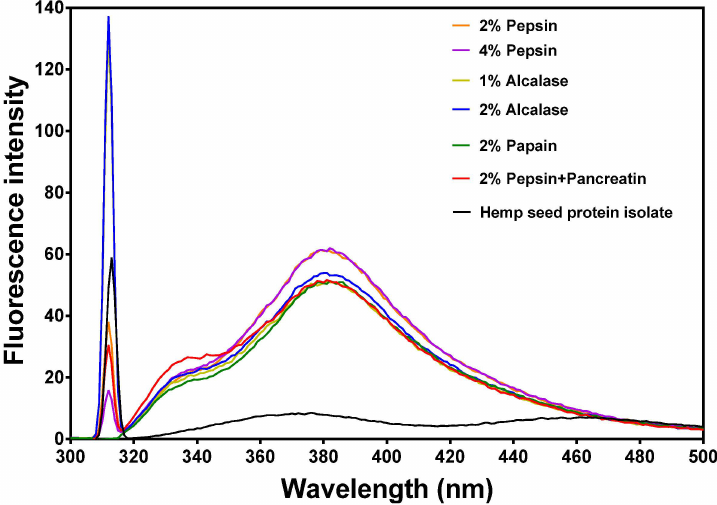
Figure 3. Intrinsic fluorescence properties of different enzymatic hemp protein